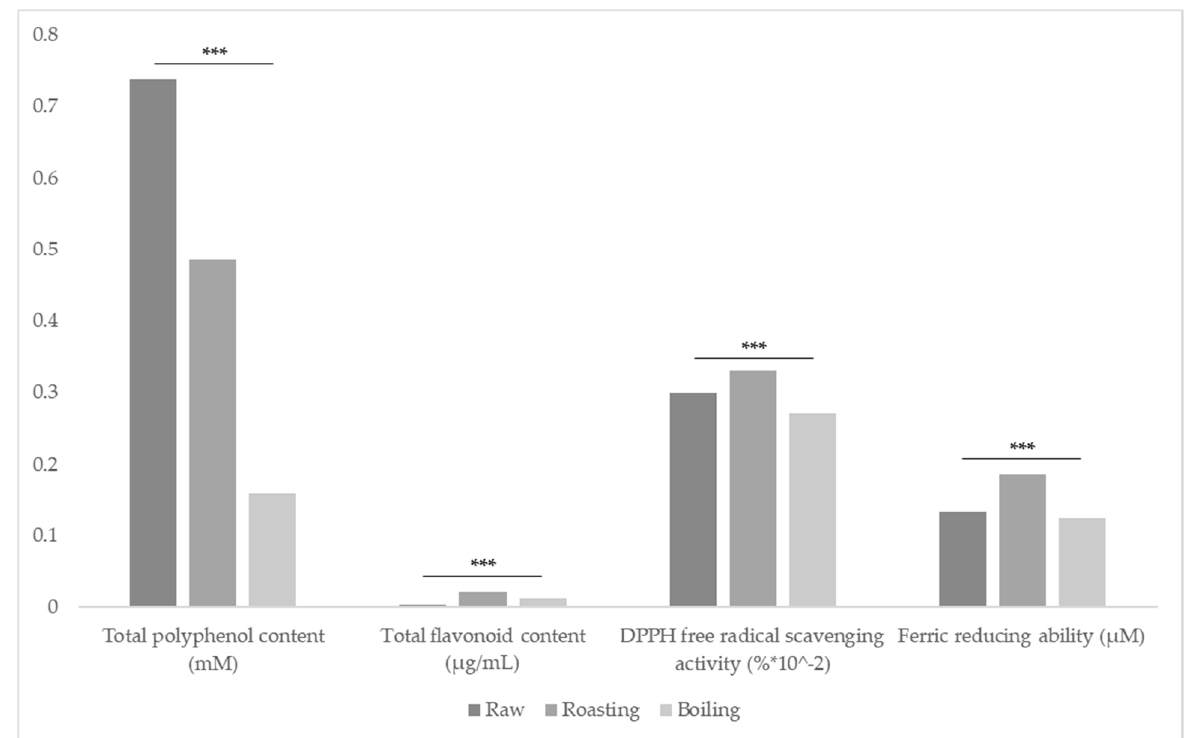
Figure 1. Analyzed antioxidant effects of raw, roasted, and boiled Sacha inchi. Data were subjected to one-way ANOVA followed by Tukey’s multiple comparisons using IBM SPSS statistics 23 (level of significance, *** p < 0.001).